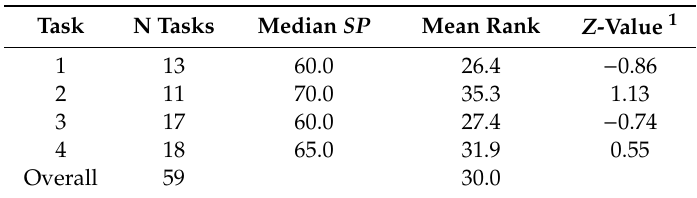
Table 3. Results of K-W test on tasks vs. use of three or four points of control. See article supplement, Table S2 for details.